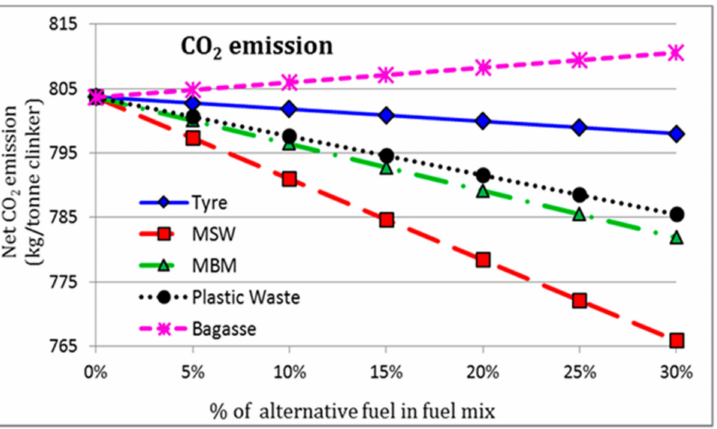
Figure 1. Net CO 2 emission for a different feed rate of waste-deriving alternative fuels: used tyres, municipal solid waste (MSW), meat and bone meal (MBM), plastic waste, and bagasse